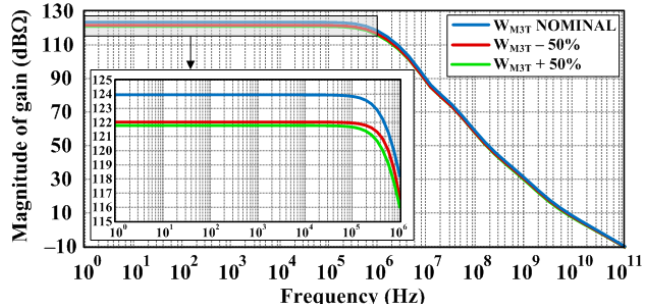
Figure 5. Magnitude of the circuit transimpedance gain as function of the frequency and by varying of ±50% the M3 T transistor width W M 3 T (from which the gm(M 3 T ) depends on), with respect to its nominal value reported in Table 1. In the inset, the magnification in the reduced range of frequencies from 1 Hz to 1